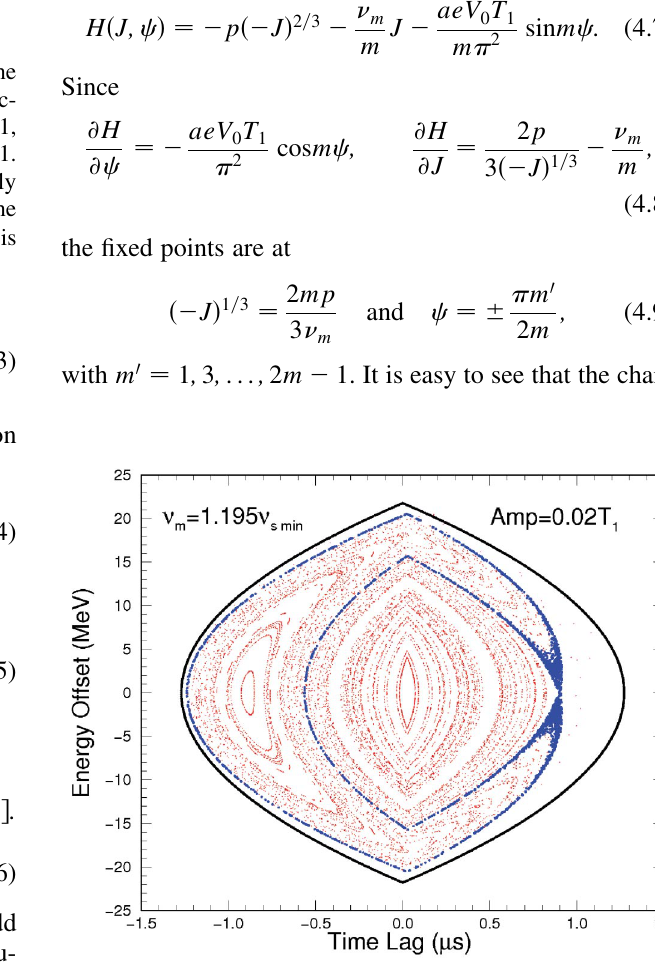
FIG. 7. (Color) Poincare´ section showing the excitation of the (cid:1) 1 : 195 (cid:4) and 1:1 resonance by rf phase modulation at (cid:4) m s; min (cid:1) 0 : 02 T modulation amplitude aT . The separatrices in thicker 1 1 curves show an unstable fixed point on the right and a stable fixed point on the left. Since the separatrices almost touch the barrier bucket boundary, particles outside the separatrices will be lost. The simulation involves initially 100 randomly but uni- formly distributed particles tracked for 5 (cid:3) 10 6 revolution turns.